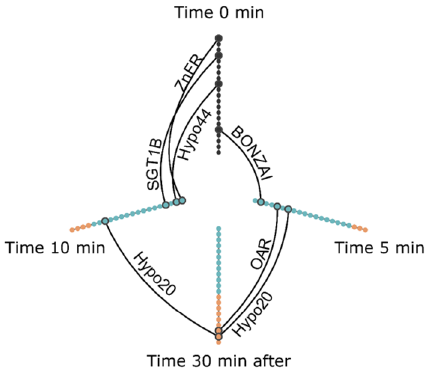
Figure 4. Hive plot depiction of statistical differences of candidate gene marker mRNA abundances depending on the heat shock treatment time. Each axis represents a time point during the heat shock at 45 °C: 0 min, 5 min, 10 min then 20 °C for 30 min. Each candidate marker gene is represented by a node and are ordered alphabetically on the top axis. On the other axis nodes are ordered according to their fold change, i.e., their transcript level under heat shock stress conditions compared to the one at time 0. On theses axes, nodes represented in blue presented a fold change lower than 1 and those in orange presented a fold change upper than 1. Edges connecting correspond to a statistical difference between the fold change of the two time points for one gene (Kruskal–Wallis followed by Dunn test, P < 0.05, n = 4).